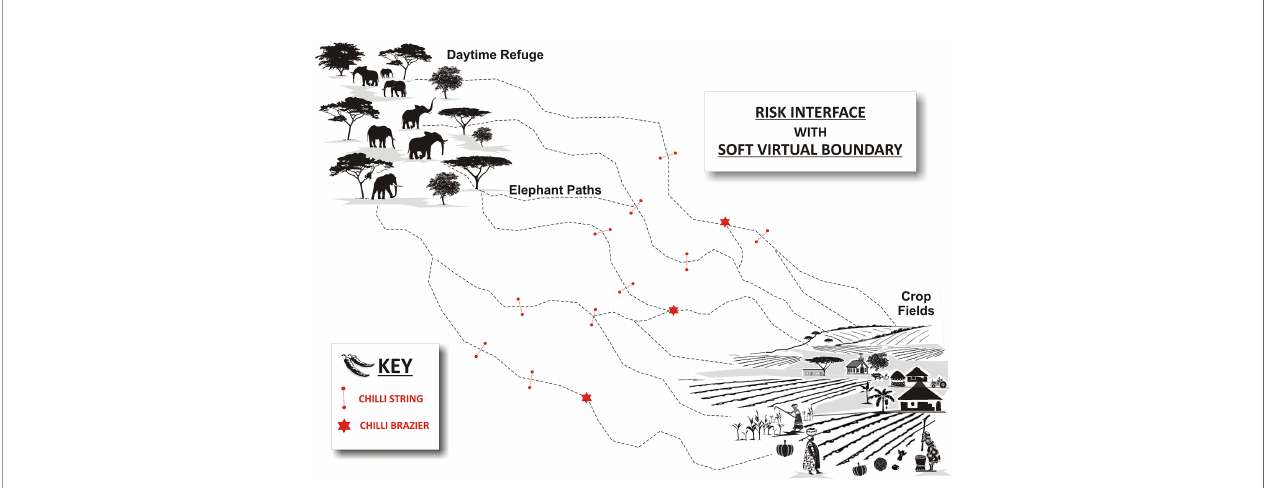
FIGURE 2 | Diagrammatic representation of a virtual boundary arrangement to deter crop raiding